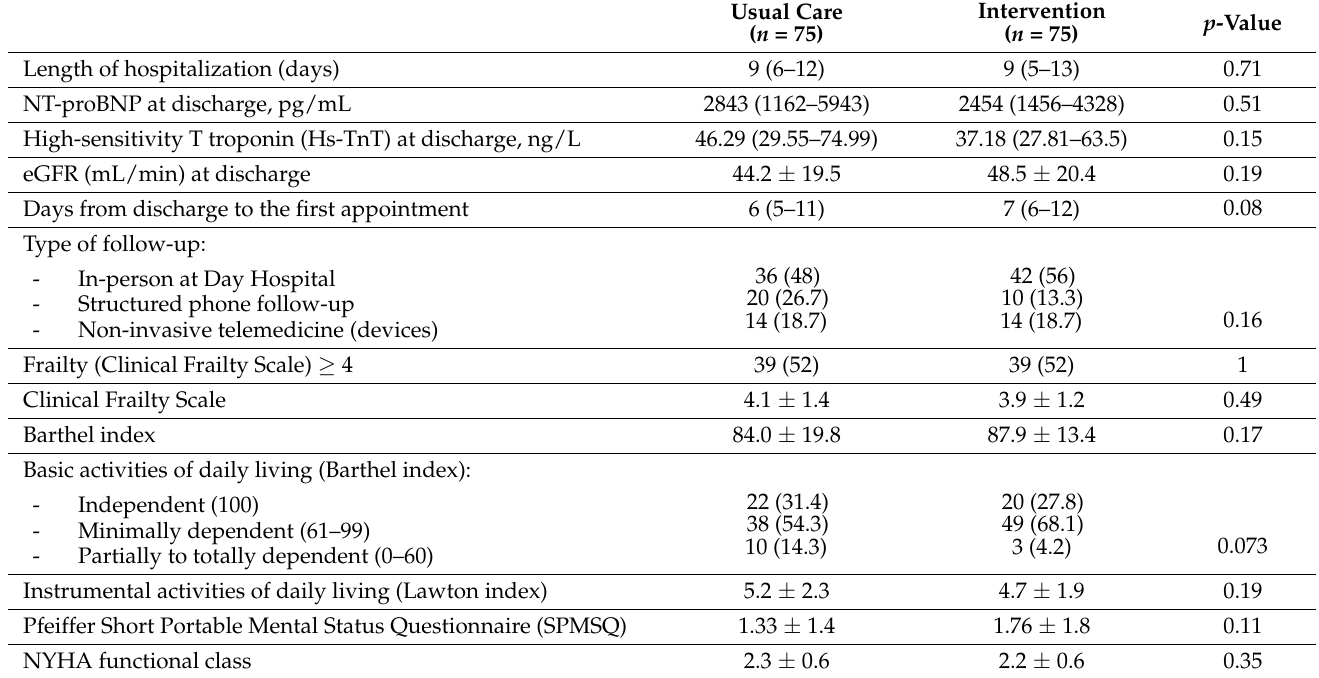
Table 2. Hospitalization and first appointment